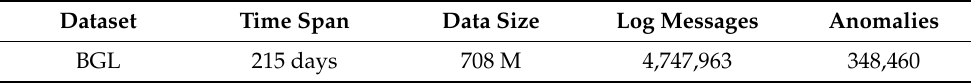
Table 3. Overview of the BGL